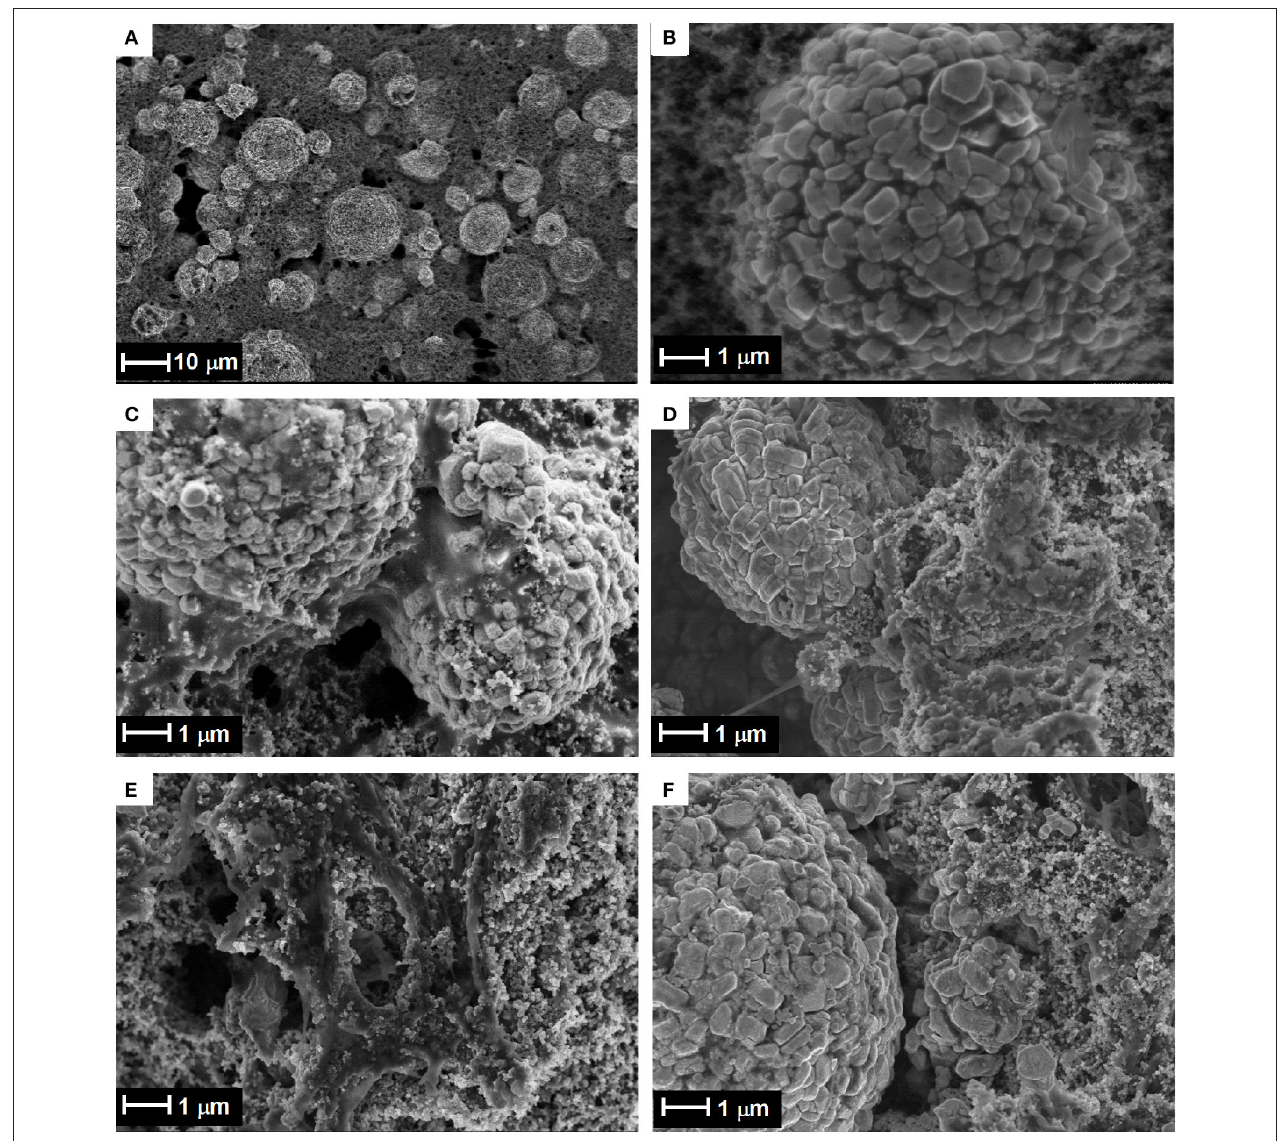
FIGURE 10 | Scanning electron microscopy images of (A) pristine material and (B) a sample taken from the center of the electrode after 65 cycles, (C) unwashed electrode and (D) washed electrode with DMC, and a sample taken from the edge of the electrode, (E) unwashed and (F) washed with